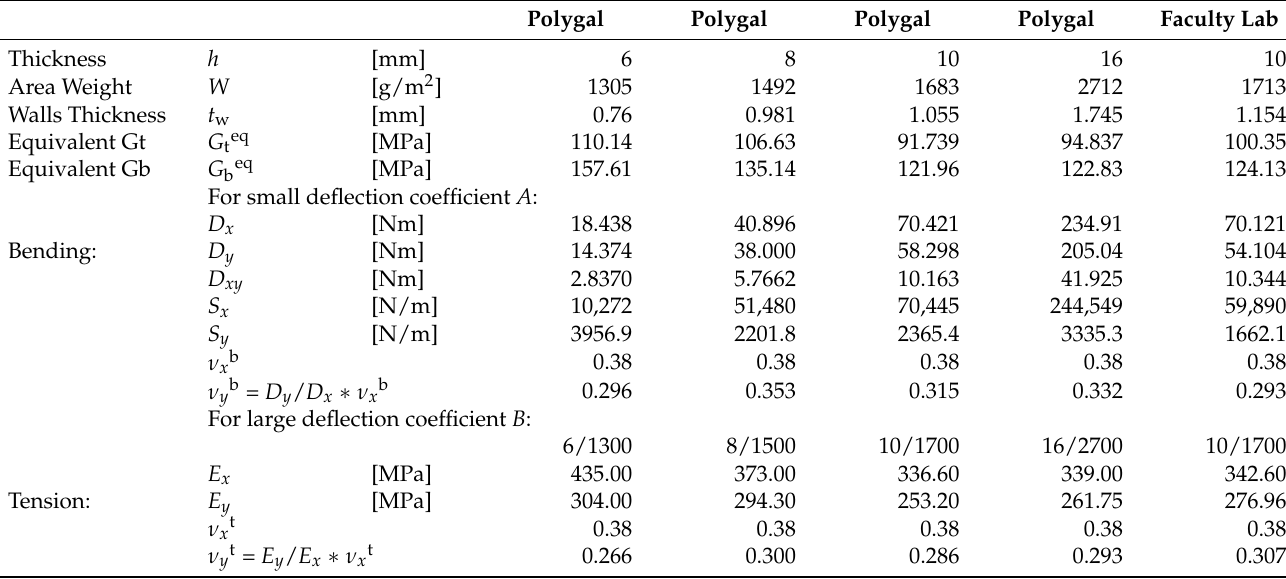
Table A2. Properties of plates used in vacuum chamber tests.